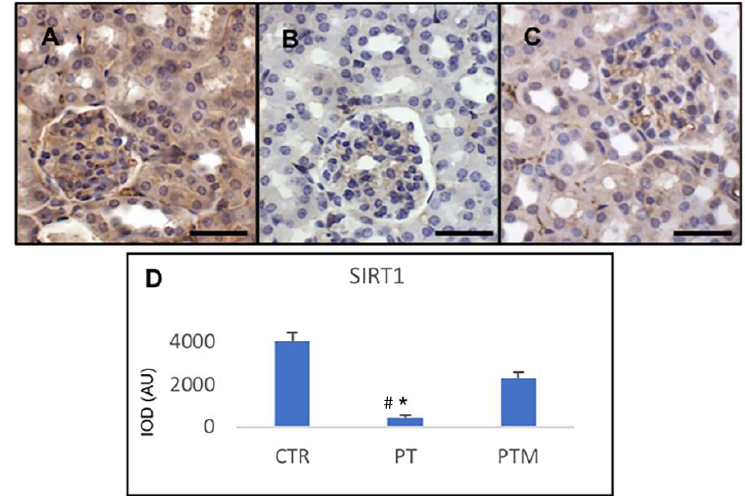
# Figure 3. Photomicrographs showing transforming SIRT1 immunohistochemistry of control mice ( A ), pristane-LN mice ( B ) and pristane-LN mice treated with melatonin ( C ). Bar equals 20 µm. The graph ( D ) summarizes SIRT1 immunohistomorphometrical analysis of all experimental groups. *# indicates respectively tatistically significant differences vs control and pristane-LN mice treated with melatonin: p < 0.05. CTR: control mice PT: pristane-LN mice PTM: pristane-LN mice treated with melatonin. Because SIRT1 expression was related to the renal Nrf2 pathway, we evaluated also Nrf2 expression.